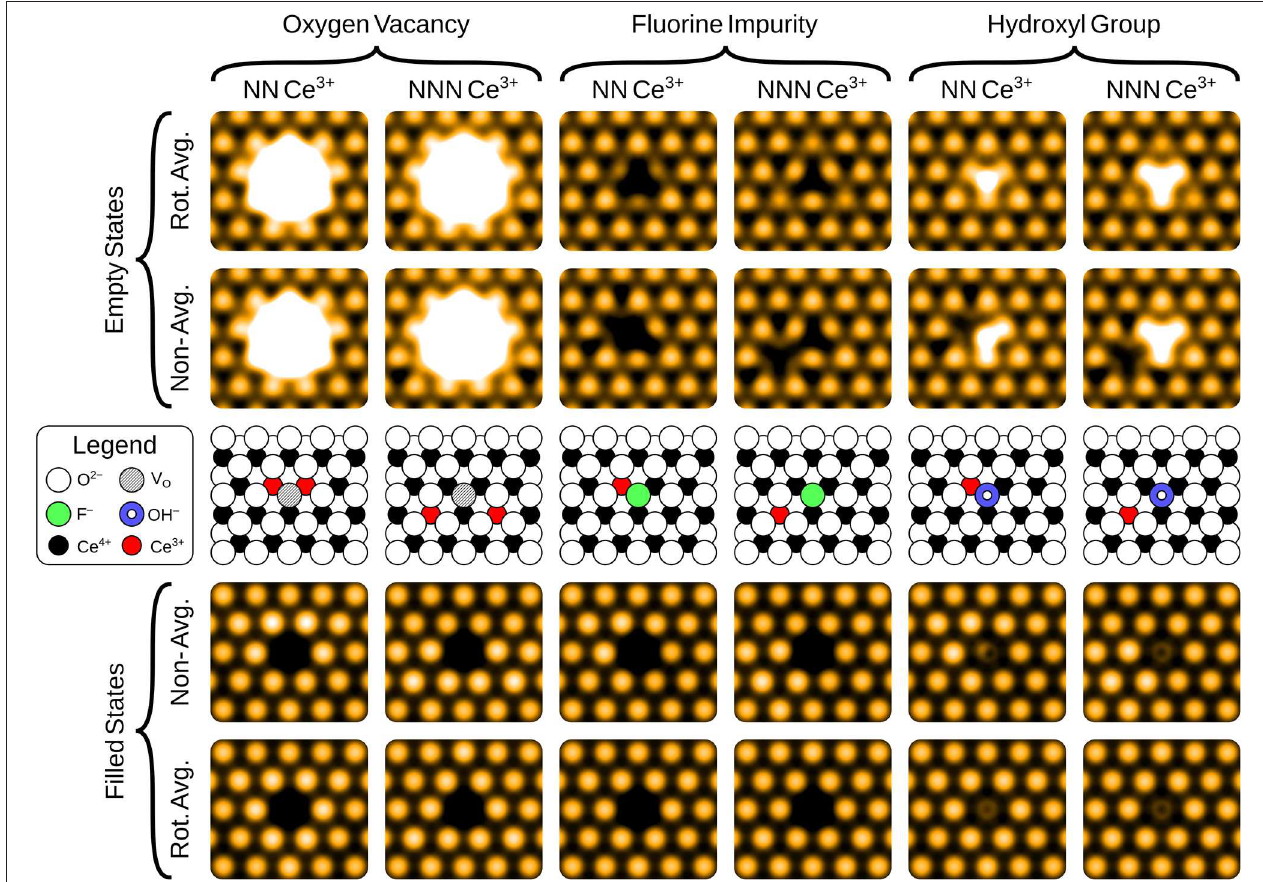
FIGURE 2 | Simulated filled and empty state images of the three surface anionic defects, with the associated Ce 3 + ions at either nearest neighbor (NN) or next nearest neighbor (NNN) lattice sites. The precise locations of the Ce 3 + ions are shown in the schematics, for comparison with the non-rotationally averaged images.